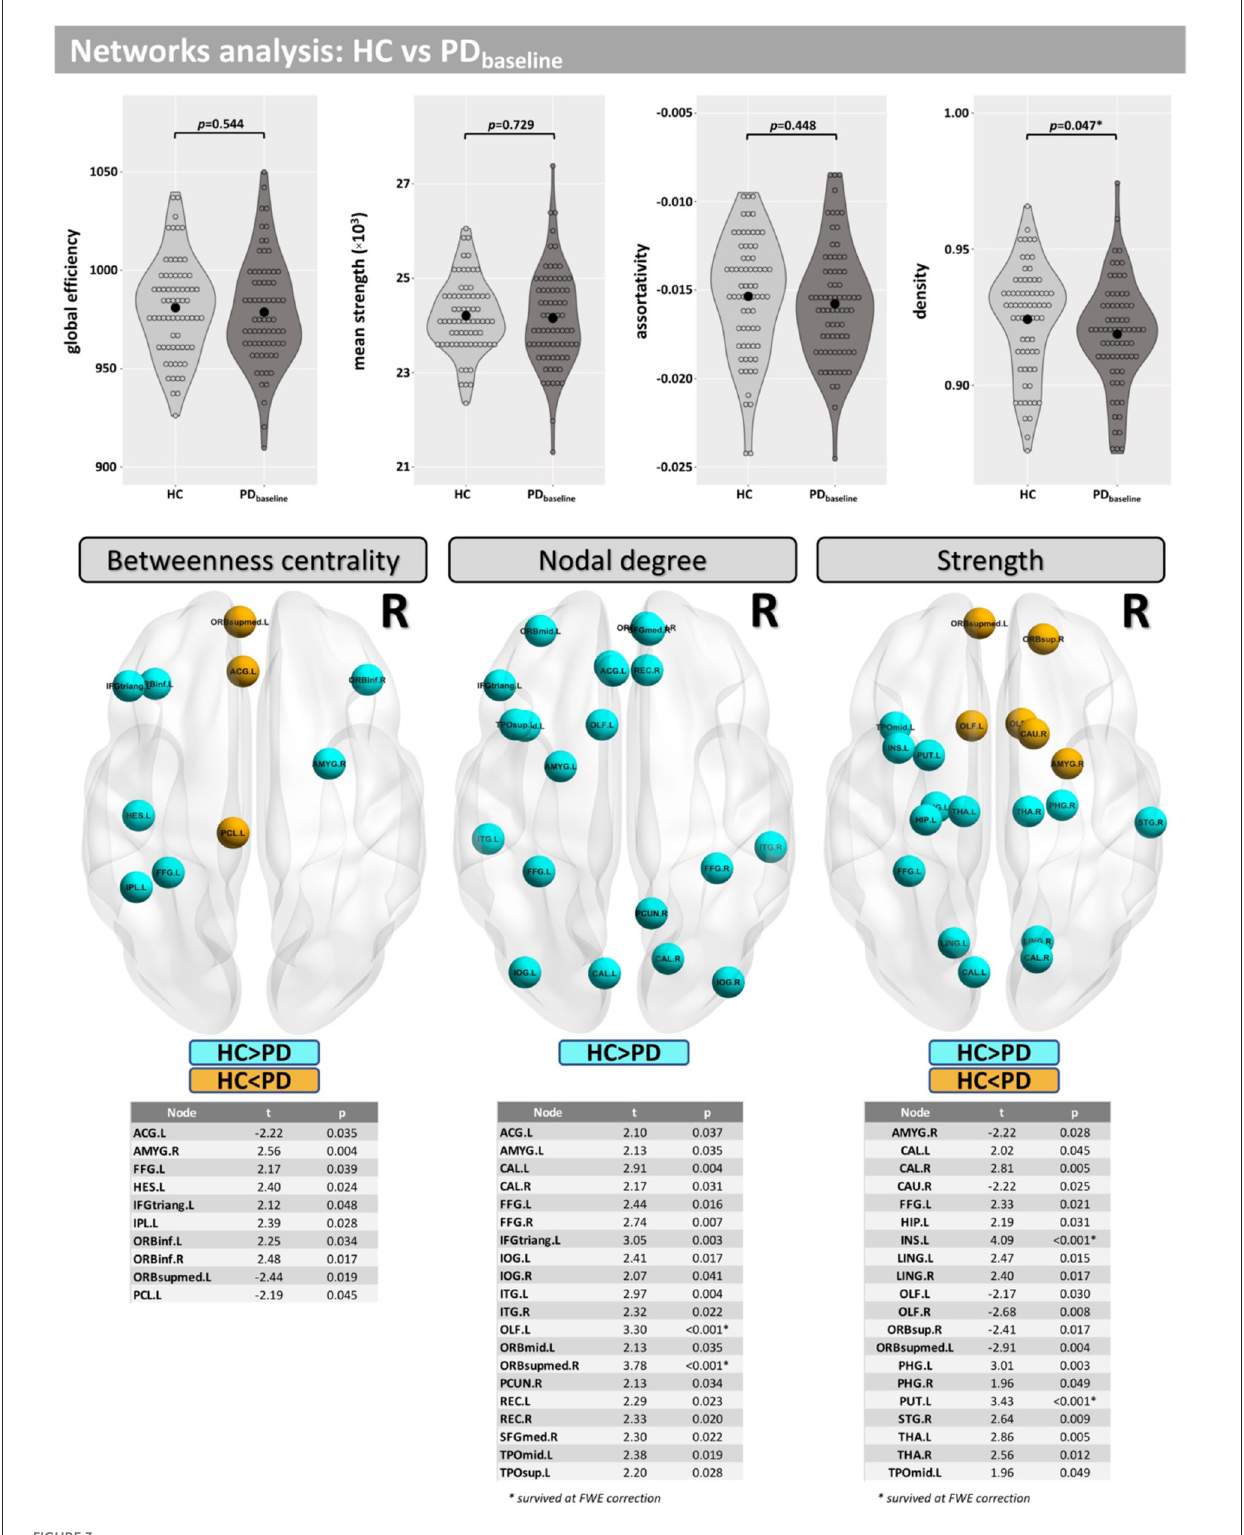
FIGURE3 Network analysis for the cross-sectional part of this study. Differences between groups were found for the network density and in several nodes for “betweenness centrality,” “nodal degree,” and